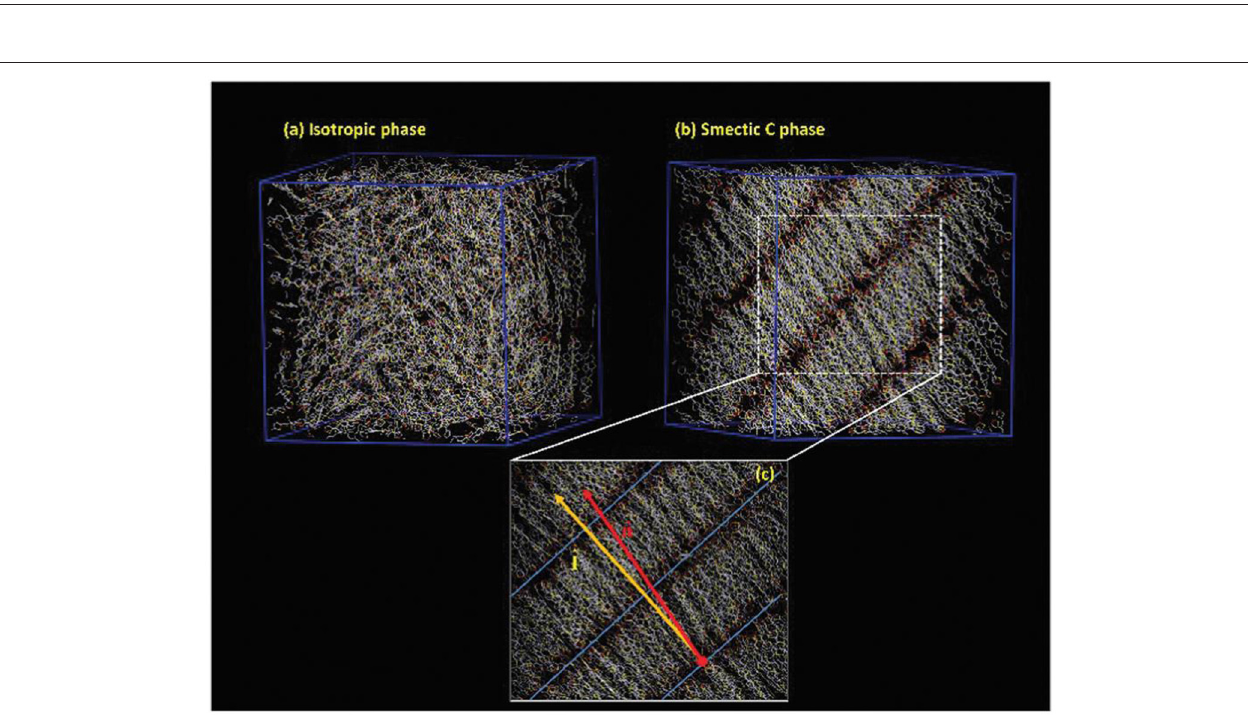
FIGURE 7 | Characteristic atomistic snapshots from the Monte Carlo simulations of Tsourtou et al. [57] of a model system of α -unsubstituted sexithiophene ( α -6T). (a) The isotropic (Iso) phase at T = 700K, (b) the smectic-C (SmC) phase at T = 680K with α -6T molecules self-organized into layered states, and (c) a zoom into the SmC phase showing the layer normal vector ˆ l and the director ˆ n of the phase. Sulfur, carbon, and end-carbon atoms of the outer rings are represented with yellow, white, and red color, respectively. Reproduced from Tsourtou et al. [57] by permission of The Royal Society of Chemistry.